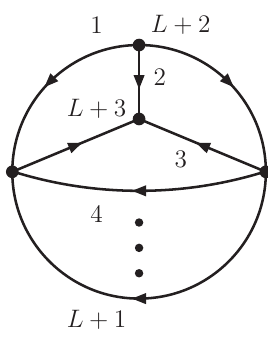
Figure 7 . N 2 MLT ( L ) diagram with L